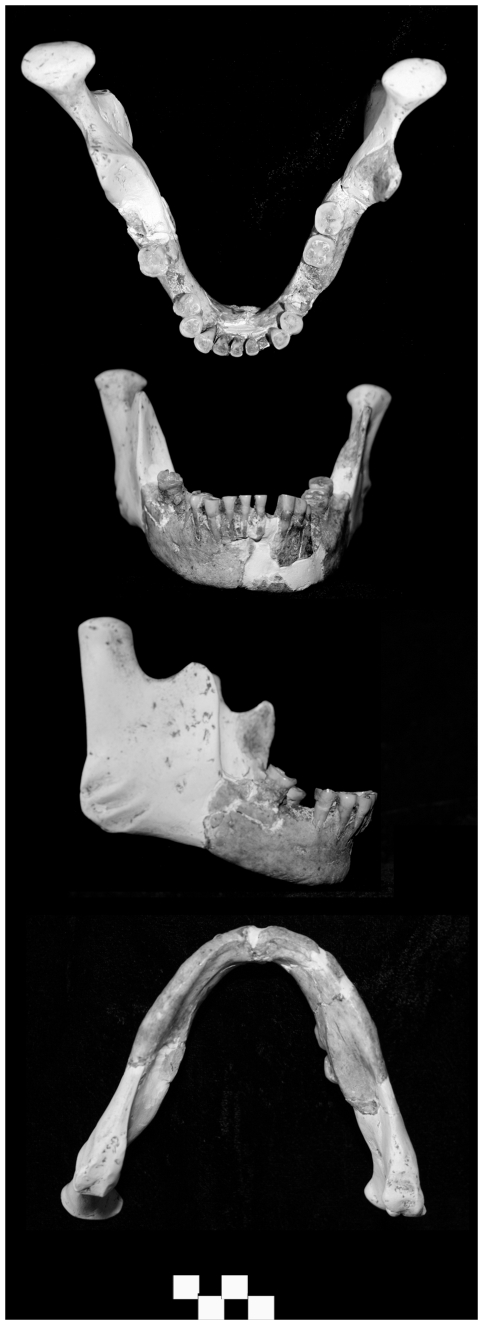
Longlin 1 mandible (scale bar = 1 cm).